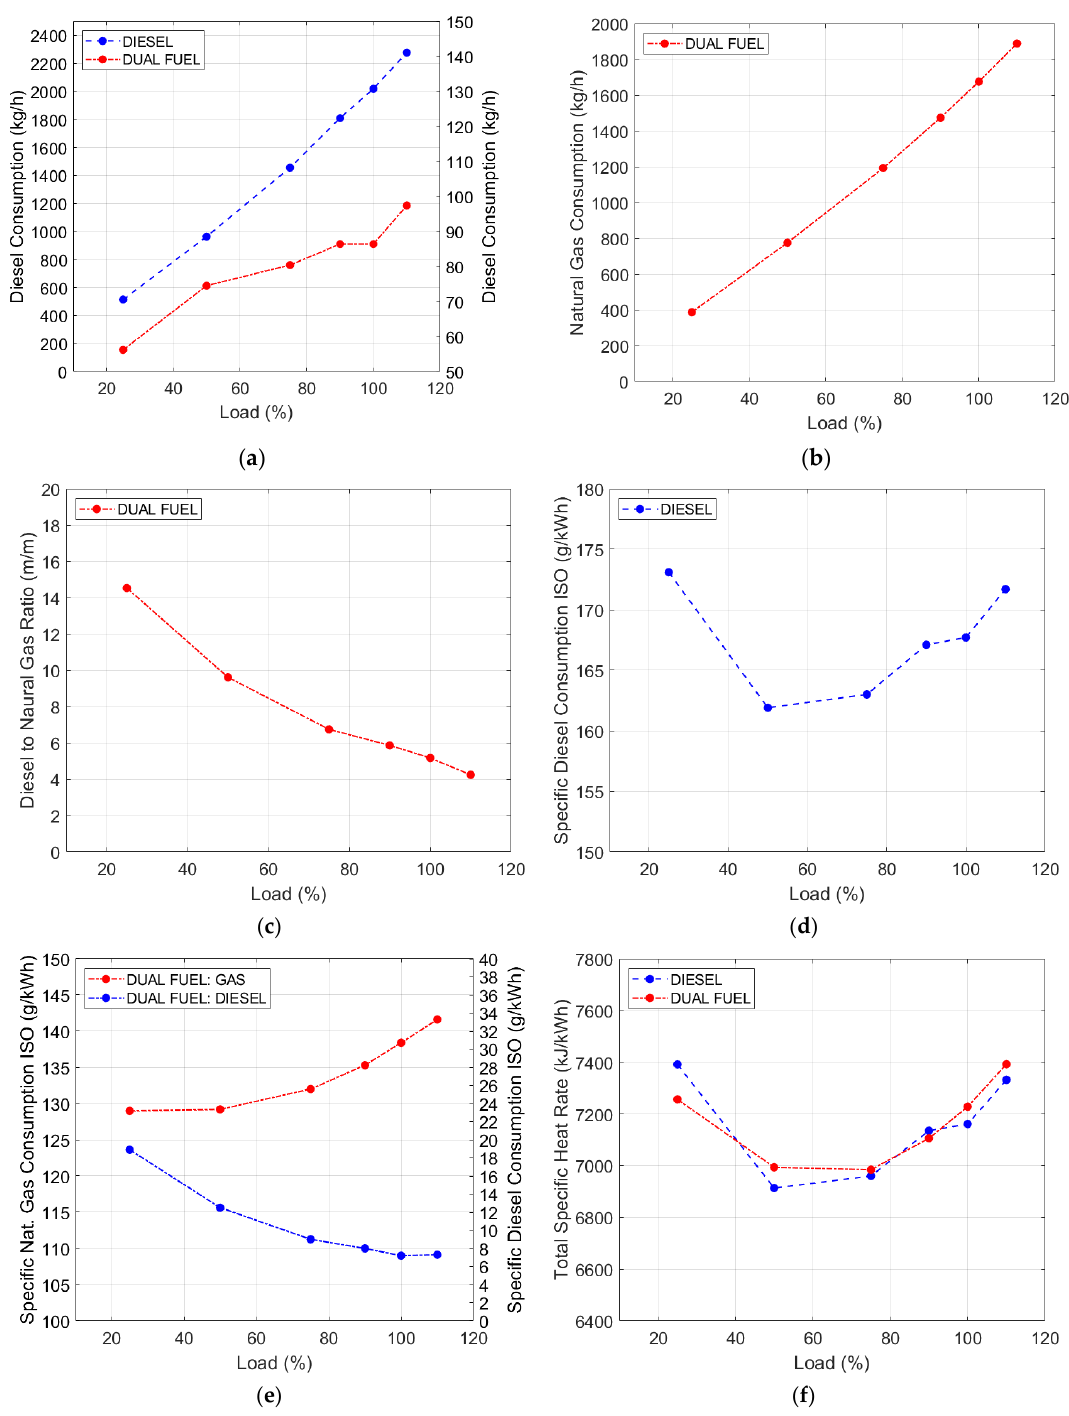
Figure 5. ( a ) Diesel consumption, diesel and DF modes; ( b ) Natural gas consumption, DF mode; ( c ) Mass ratio of diesel to natural gas; ( d ) Speci fi c fuel consumption ISO, diesel mode; ( e ) Speci fi c nat- ( c ) Mass ratio of diesel to natural gas; ( d ) Specific fuel consumption ISO, diesel mode; ( e ) Specific ural gas and diesel consumption ISO, DF mode; ( f ) Cumulative speci fi c heat rate, diesel and DF natural gas and diesel consumption ISO, DF mode; ( f ) Cumulative specific heat rate, diesel and modes. DF